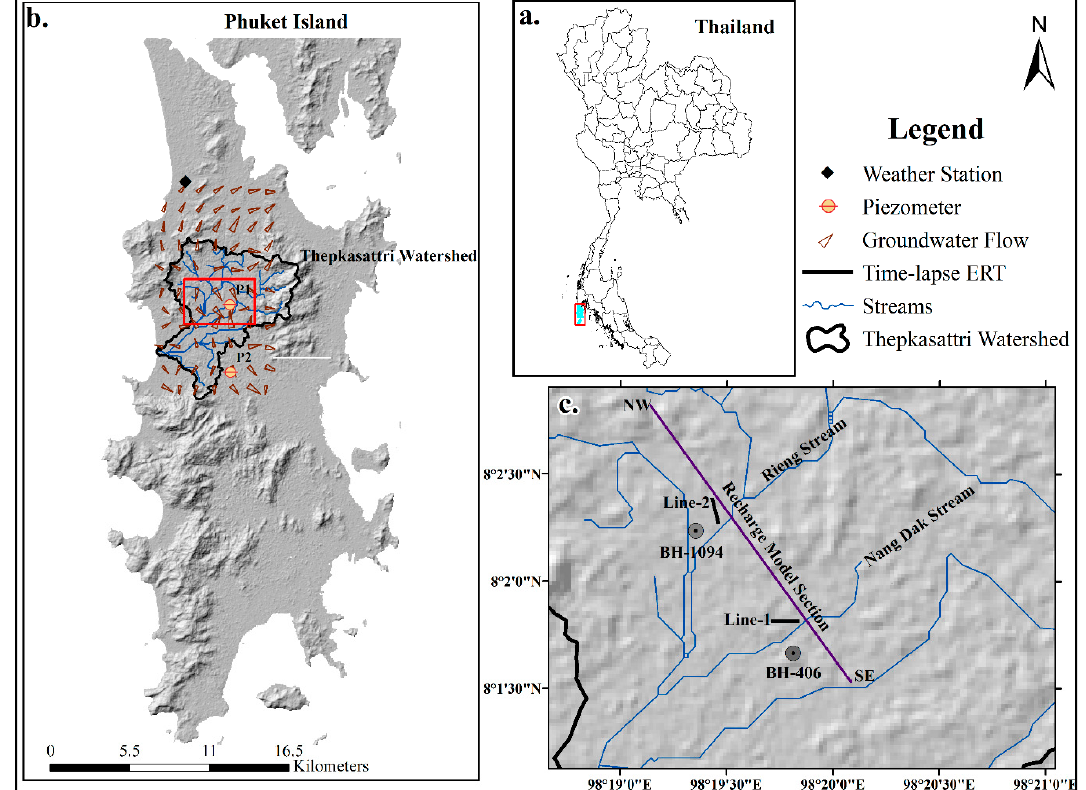
Figure 1. Maps of the study area and groundwater flow directions. ( a ) Thailand map, the highlighted red box shows Phuket Island; ( b ) Phuket Island, the red box indicates the location of the study area, weather station and piezometer (P1: Wat Phra Thong, P2: College of Disaster Prevention and Mitigation (CDPM); ( c ) Electrical resistivity tomography (ERT) survey lines (Line-1: alongside Nang Dak stream and Line-2: alongside Rieng stream), boreholes (BH) and recharge model sections.